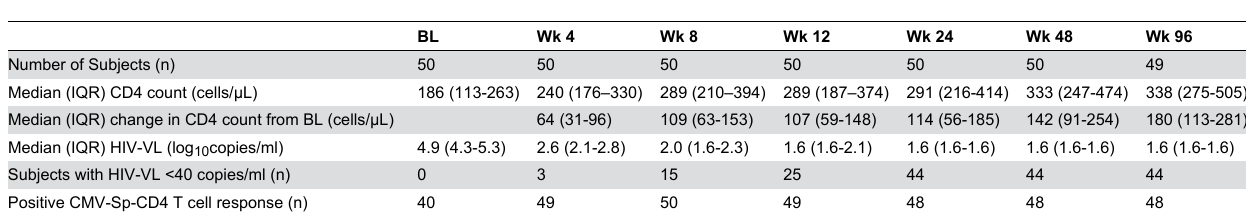
Table 2. Immunologic and Virologic responses to ART.